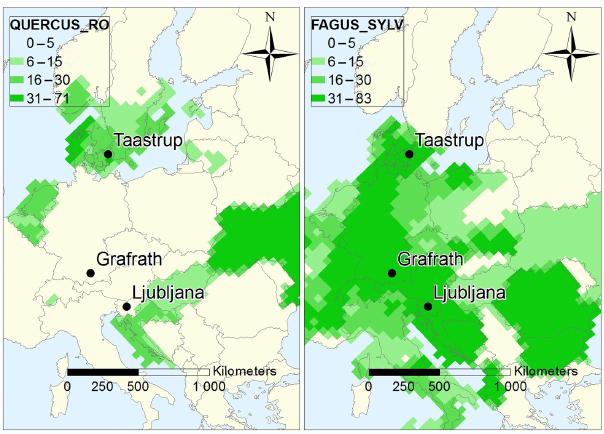
Figure 1. European map over visited International Phenological Garden sites and the reported gridded tree density in percentage of English oak (left) and European beech (right). The sites used in this study are located in Slovenia (Ljubljana), Germany (Grafrath, 30km W of Munich) and Denmark (Taastrup, 15kmW of Copen- hagen). The maps are redrawn from Skjøth et al. (2008), with per-